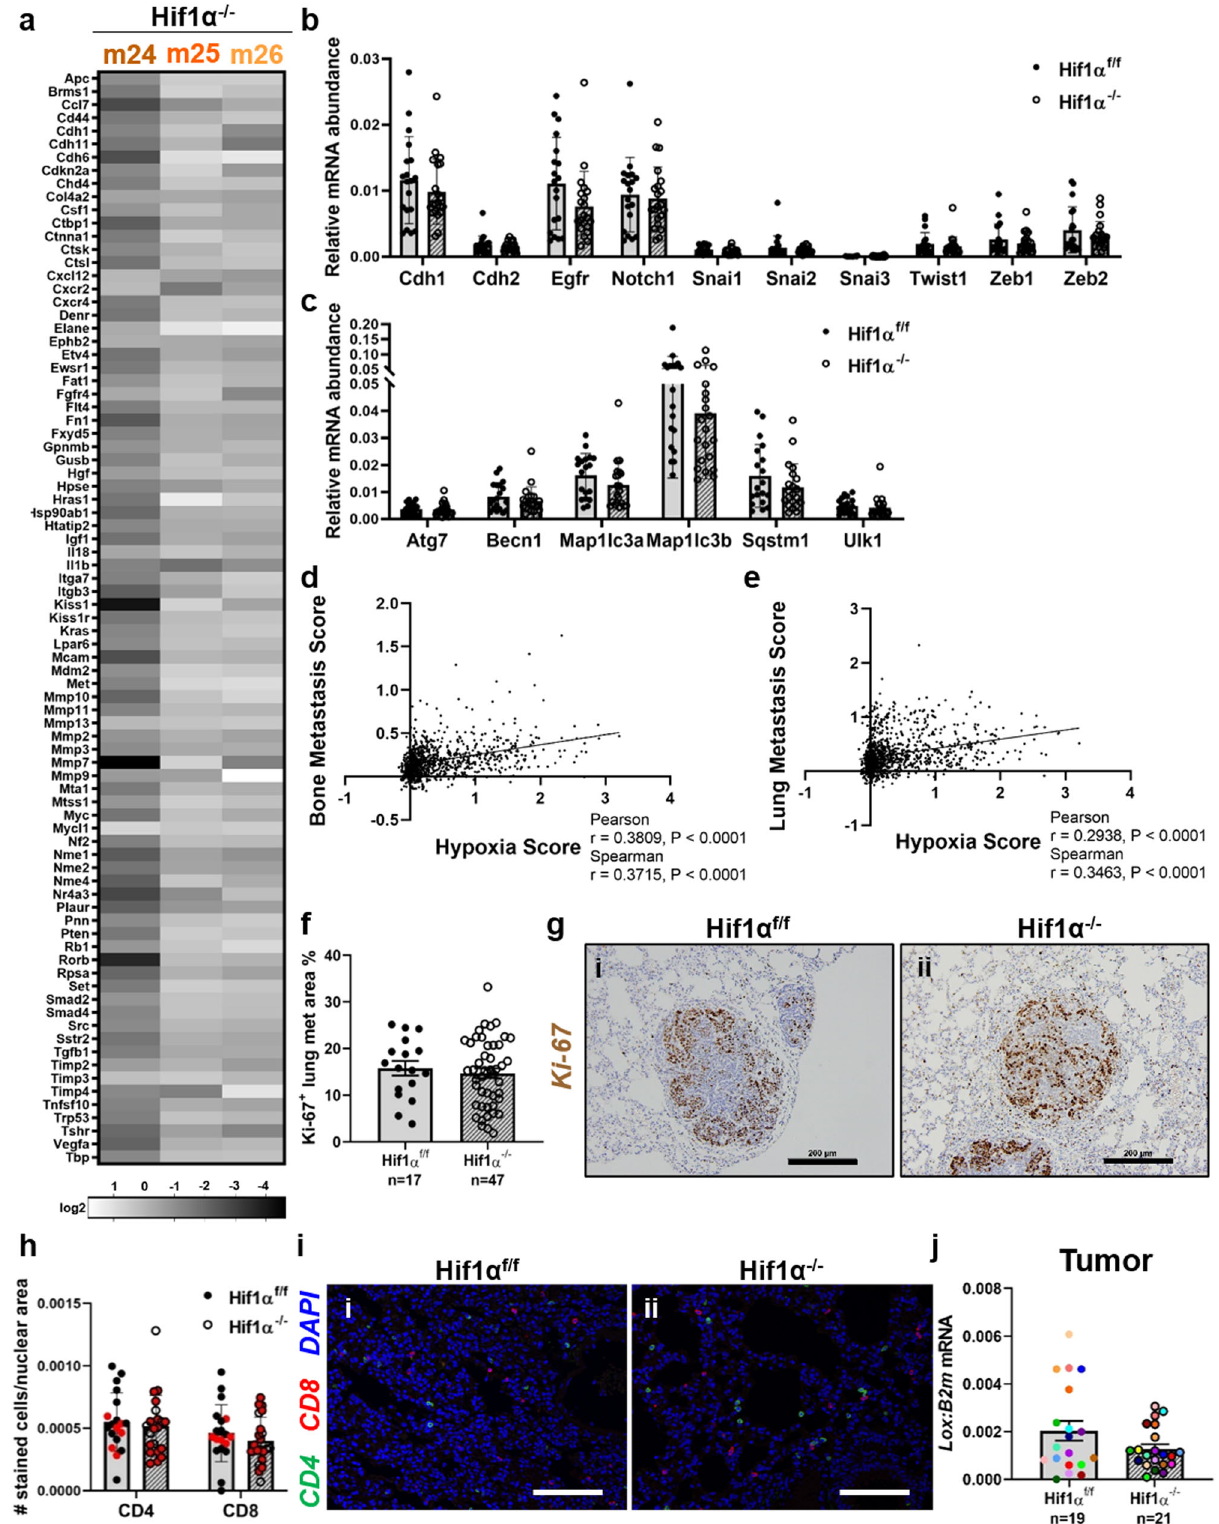
cells, such as L1 cell adhesion molecule, as well as genes that decrease adhesion between endothelial cells, such as angiopoietin-like 4 63 . Speci fi c downstream effectors of HIF signaling that prepare the lung microenvironment for meta- static colonization, such as LOX and LOX-like proteins (LOXL2 and LOXL4), have also been identi fi ed 23,65 . A